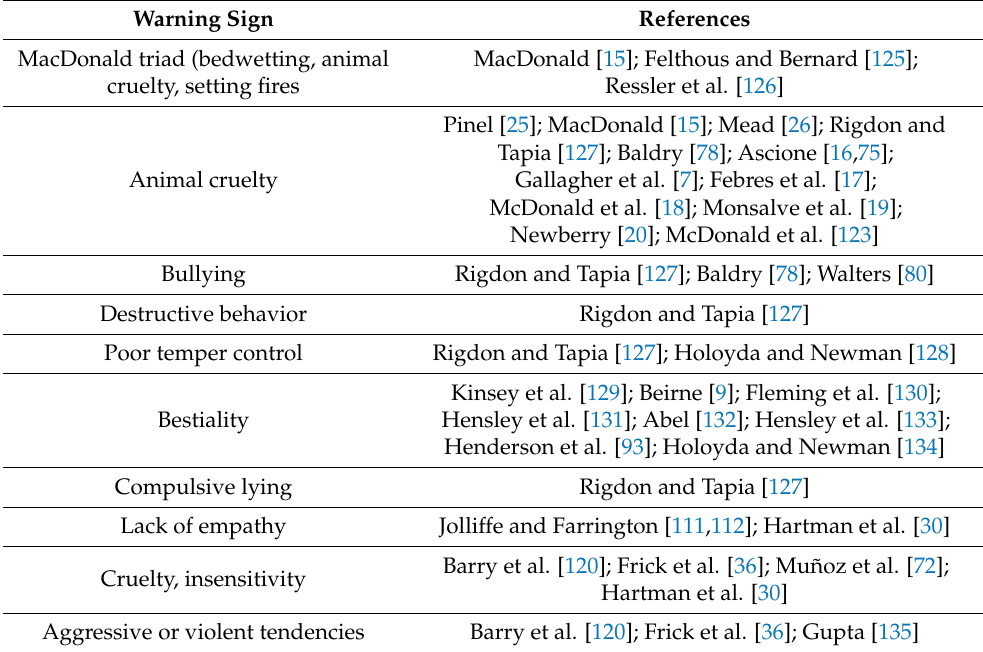
Table 2. Studies investigating warning signs to identify and prevent interpersonal (domestic or community